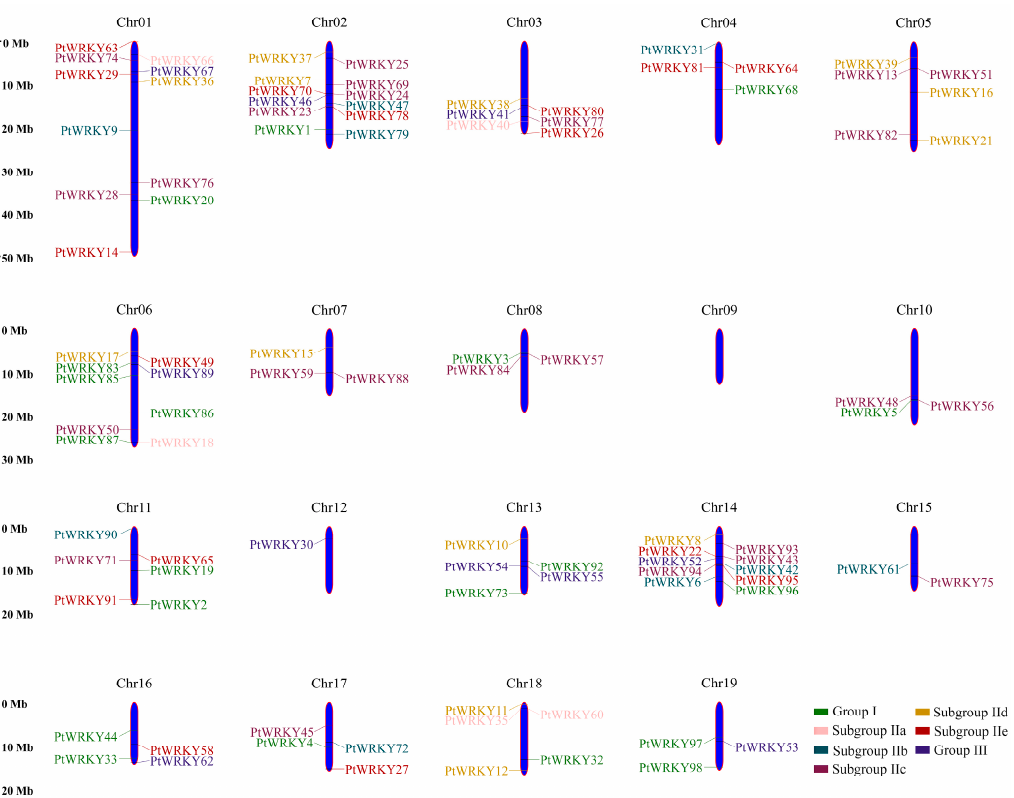
Figure 2. Chromosomal mapping of PtWRKYs . The blue bars displayed the chromosome of poplar. Genes IDs with different colors belong to different subgroups.